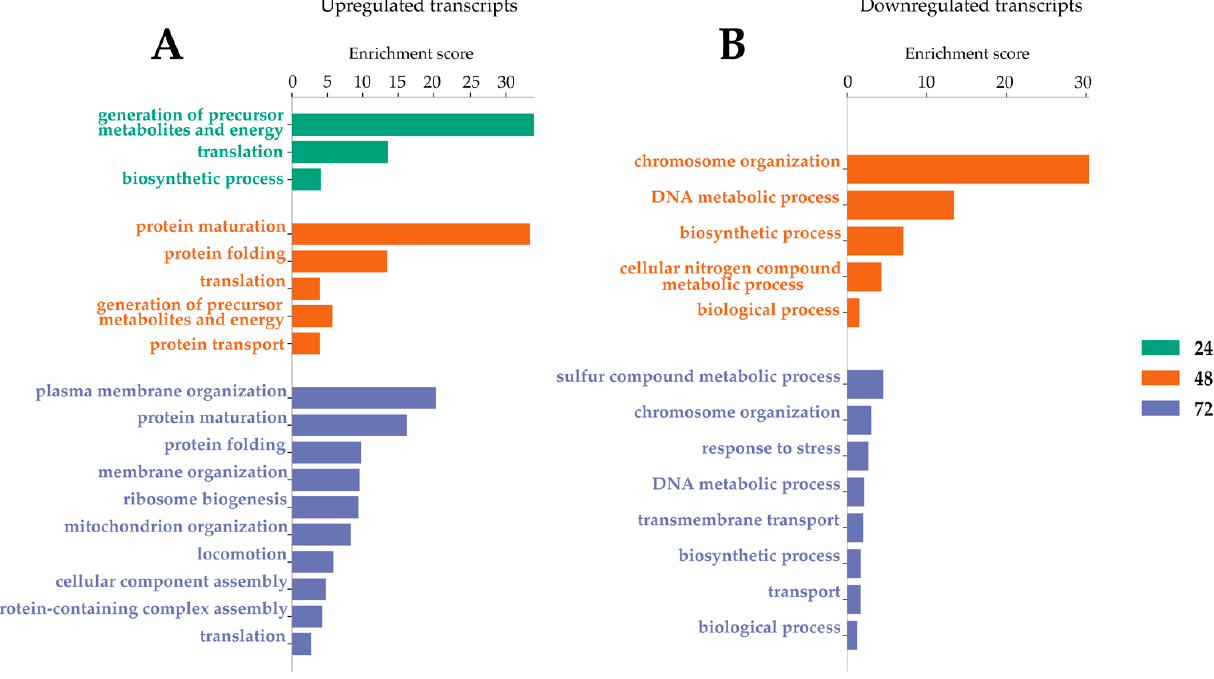
Figure 3. Gene ontology enrichment analysis for biological processes after LamV infection. ( A ) GO slim terms for up-regulated transcripts. ( B ) GO slim terms for down-regulated transcripts.